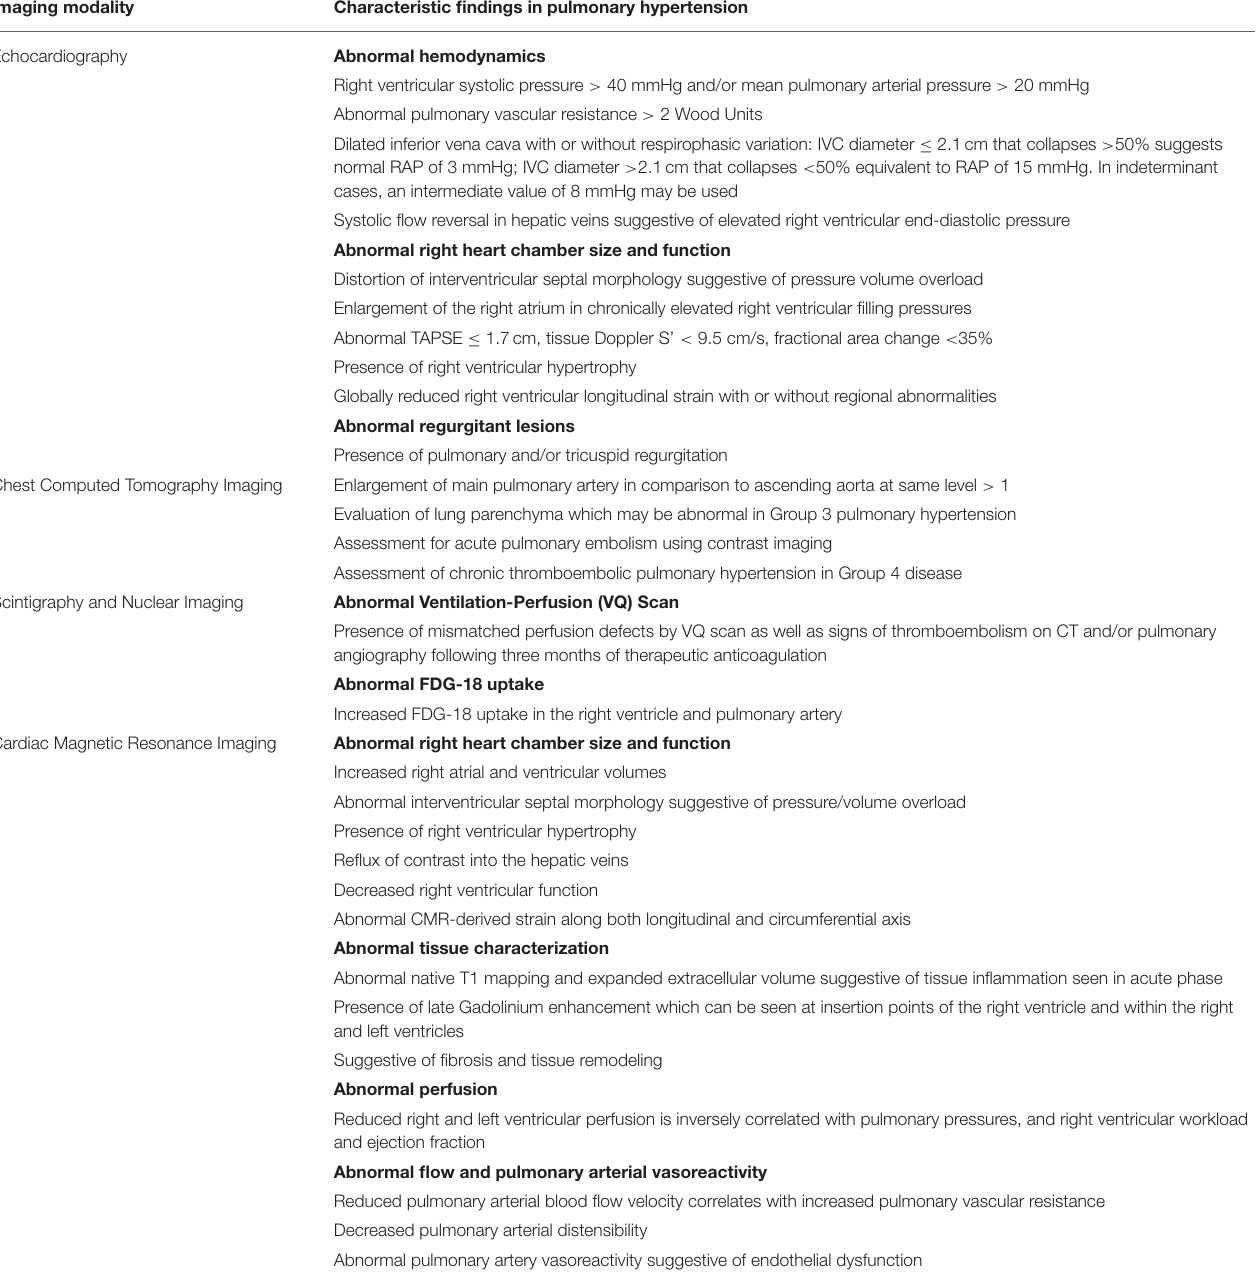
TABLE 1 | Characteristic imaging findings are summarized across imaging modalities. Imaging